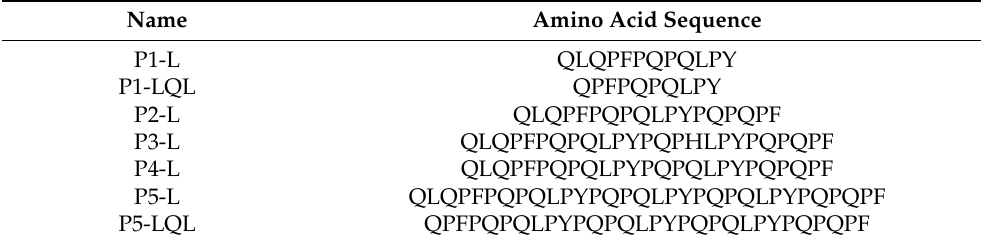
Table 3. The proteolytic products of peptides P1–P5 detected during the digestion of sourdough and fast fermentation bread. Amino acid sequence displays one letter amino acid code. L represents leucine and LQL represents a Leu-Gln-Leu tripeptide.